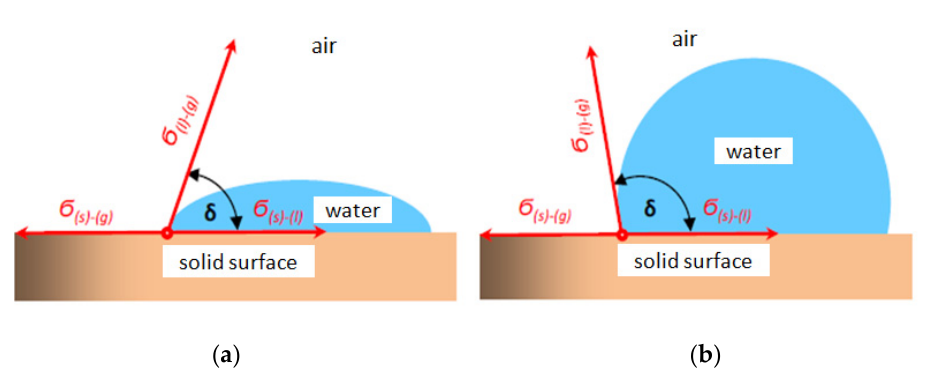
Figure 2. Representation of the contact angle for solid surfaces: ( a ) Water on the hydrophilic surface; ( b ) Water in the form of a drop on the hydrophobic surface.